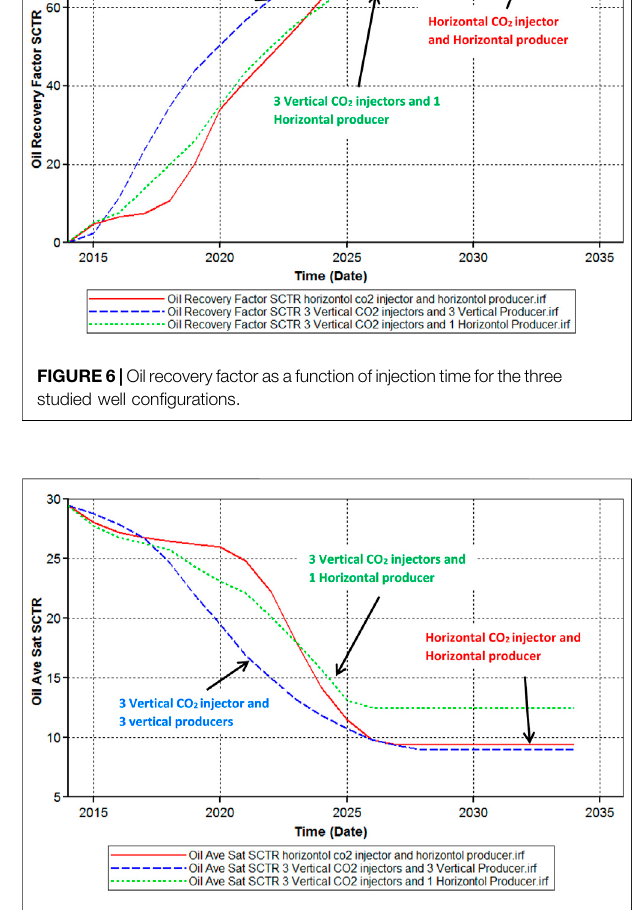
Frontiers in Energy Research |